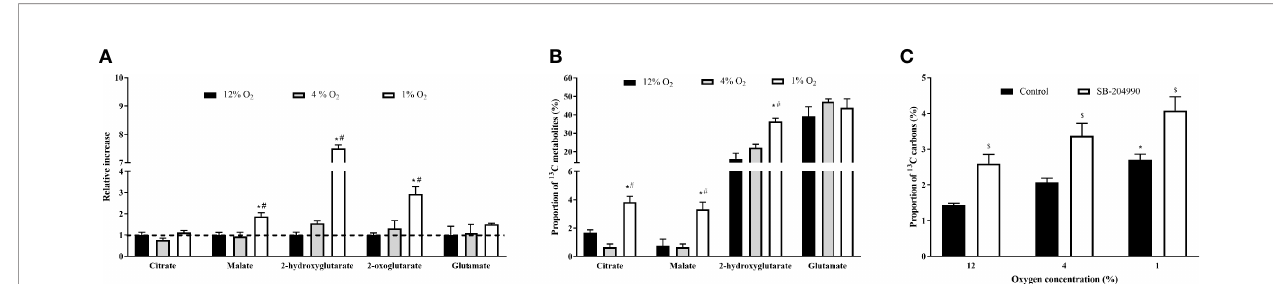
FIGURE 3 | The Effect of Hypoxia on Incorportaion of 13C to rTCA Metabolites and Fatty Acids. The effect of hypoxia on quantity of metabolites generated in rTCA (A) . Incoporation of 13 C derived form 1- 13 C-labelled glutamine to metabolites generated in rTCA, subtracted from the effect of non-labelled glutamine (B) and percentage of 13 C carbon derived from 5- 13 C-labelled glutamine in intracellular palmitate (C) . *p < 0.05 for comparison with 12% O 2 (ANOVA, A - N = 3, B, C – N = 6); # p < 0.05 for comparsion with 4% O 2 exposures (ANOVA, A - N = 3, B, C – N = 6); $ p < 0.05 for comparsion with DMSO - Control (ANOVA, N = 6).